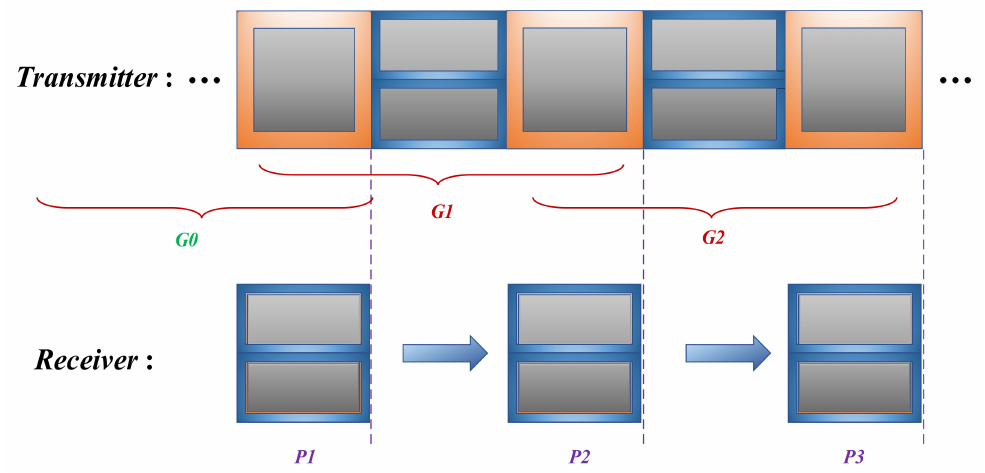
Figure 8. The diagram of the proposed switching